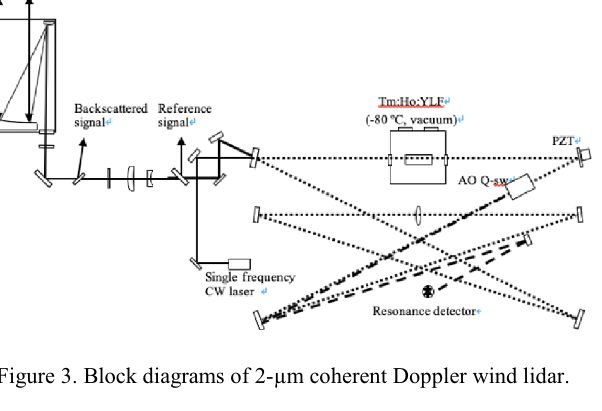
Figure 3. Block diagrams of 2-μm coherent Doppler wind lidar.